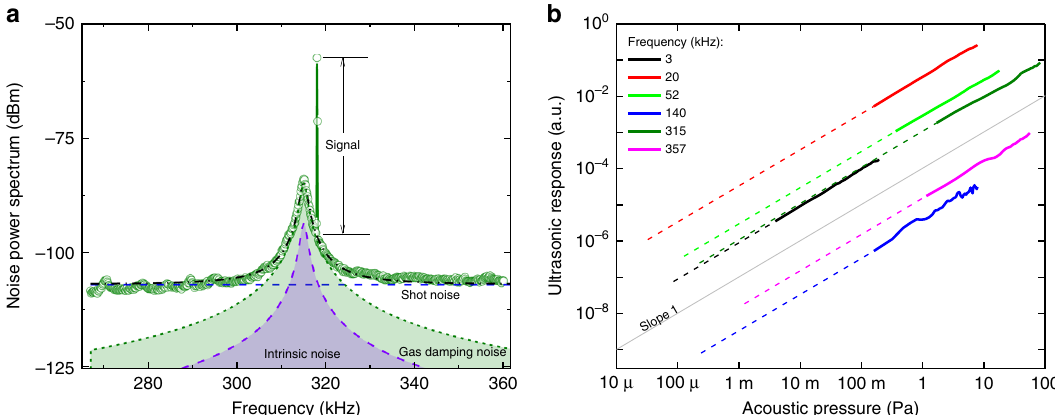
Fig. 4 Evaluation of the noise equivalent pressure sensitivity and the linear dynamic range. a Noise spectral density of the sensor near a mechanical mode of the microdisk measured at an electrical bandwidth of 200 Hz. An ultrasonic pressure of 120 mPa at frequency of 318 kHz is applied to the device resulting in a signal-to-noise ratio of ~40 dB. The shot noise is shown with the dashed blue line. The thermomechanical noise introduced by intrinsic and gas damping is shown, respectively, by the purple and green shaded Lorenztian ’ s. The total noise is fi tted with the black dash-dot line, in good agreement with theory, and is dominated by gas damping noise between 306 and 325 kHz. b Ultrasonic response of the sensor at different frequencies as a function of ultrasonic pressure. The dashed grey line is a guide to the eye indicating the expected slope for a linear response. The linear dynamic range (LDR) is >120 dB for a measurement integration time of 1 s, with its upper limit dictated by the measurement setup rather than the acoustic response. The solid lines correspond to the measured data for each frequency and the dashed lines connect these to the noise equivalent pressure that sets the lower limit of the